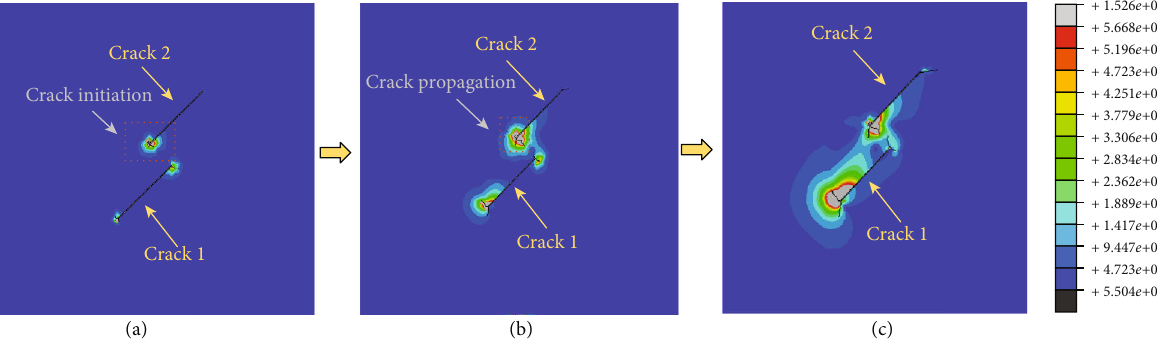
Figure 14: Model 1 stress distribution in numerical simulation. (a) t = 1 : 4 s . (b) t = 2 : 5s . (c) t = 4 : 0 s